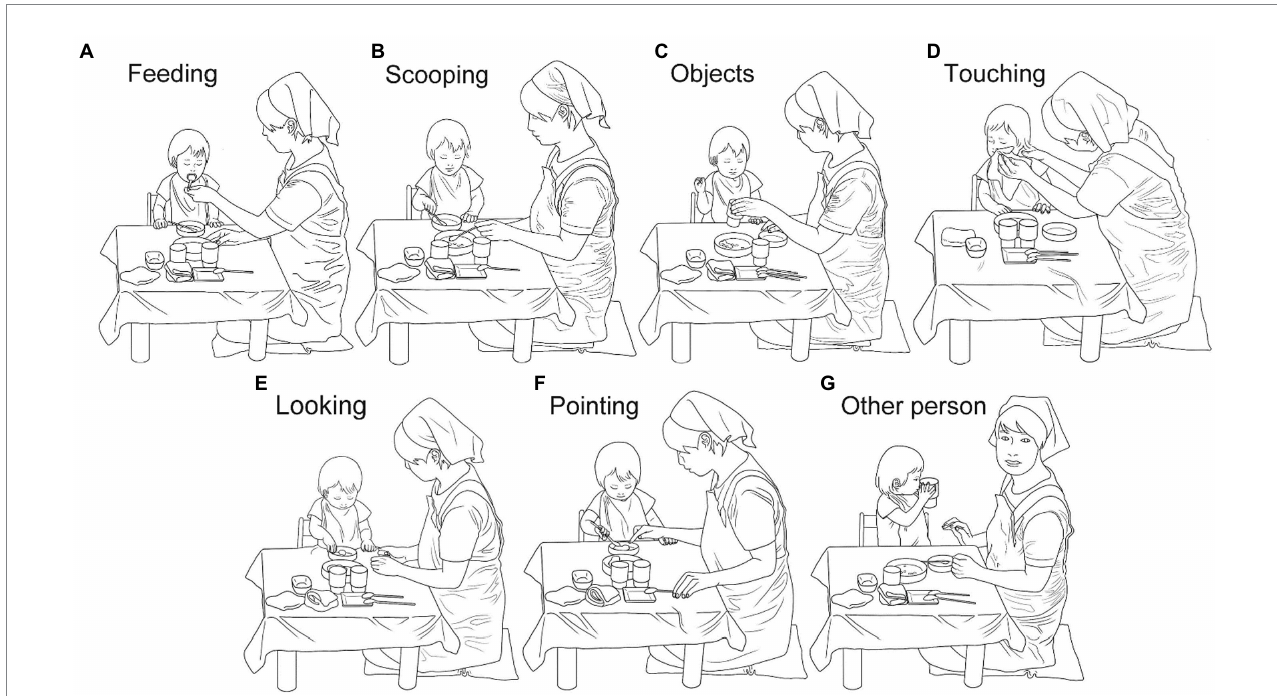
FIGURE 1 Seven categories of caregiver behaviors used in the analysis; (A) feeding: A caregiver feeds a toddler. (B) scooping: A caregiver scoops food. (C) objects: A caregiver handles objects (e.g., plates or towels). (D) touching: A caregiver touches a toddler to assist her/him. (E) looking: A caregiver looks at a toddler without being engaged in other observable tasks. (F) pointing: A caregiver points at objects on the table. (G) other person: A caregiver attends to other toddlers or